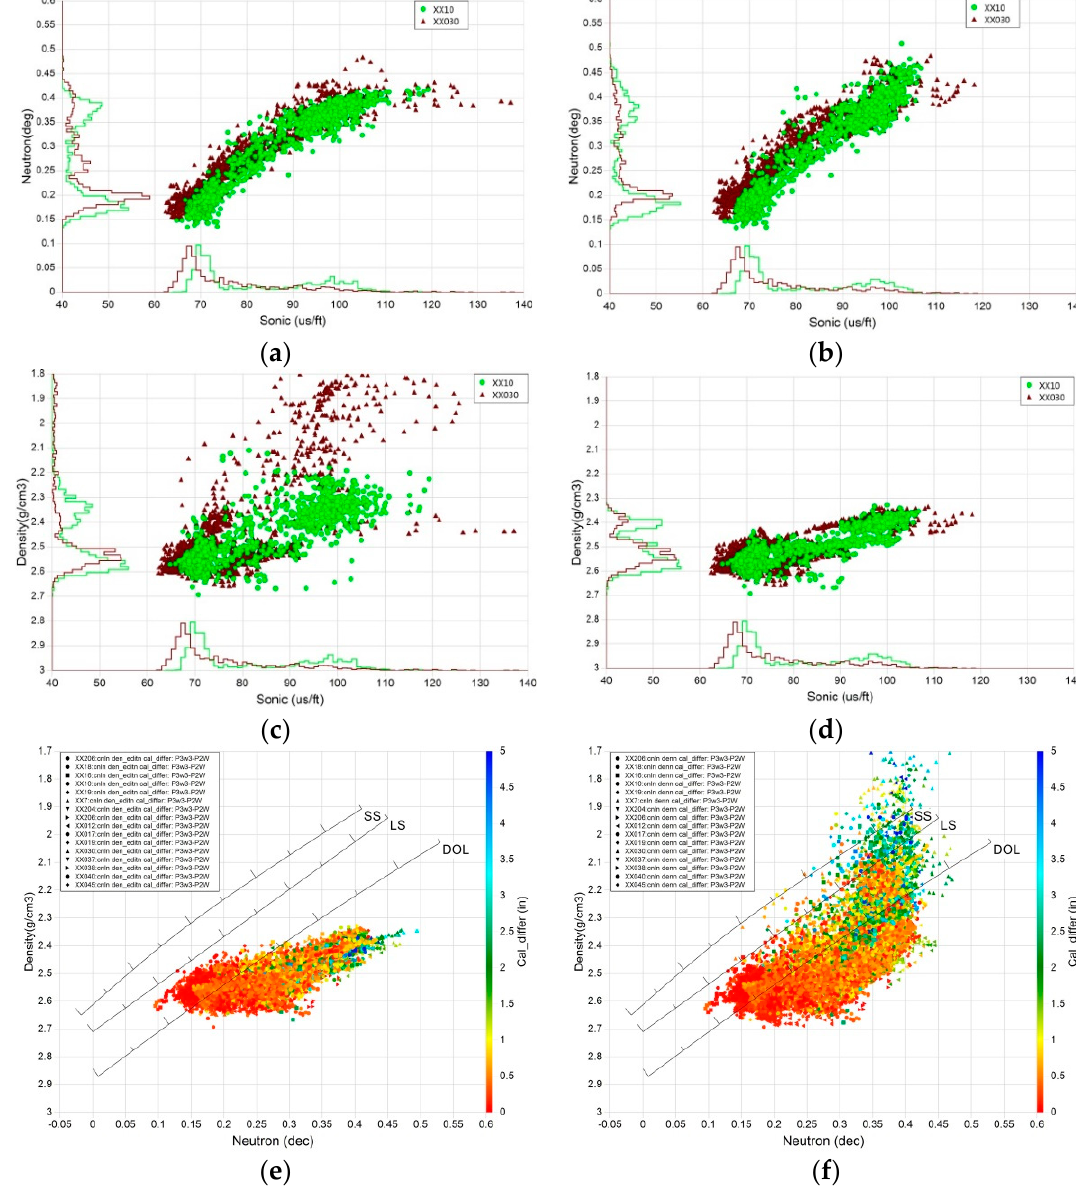
Figure 5. Comparisons of crossplots before and after corrections. ( a ) acoustic-neutron crossplot before corrections. ( b ) acoustic-neutron crossplot after corrections. ( c ) acoustic-density crossplot before corrections. ( d ) acoustic-density crossplot after corrections. ( e ) neutron-density crossplot before corrections. ( f ) neutron-density crossplot after